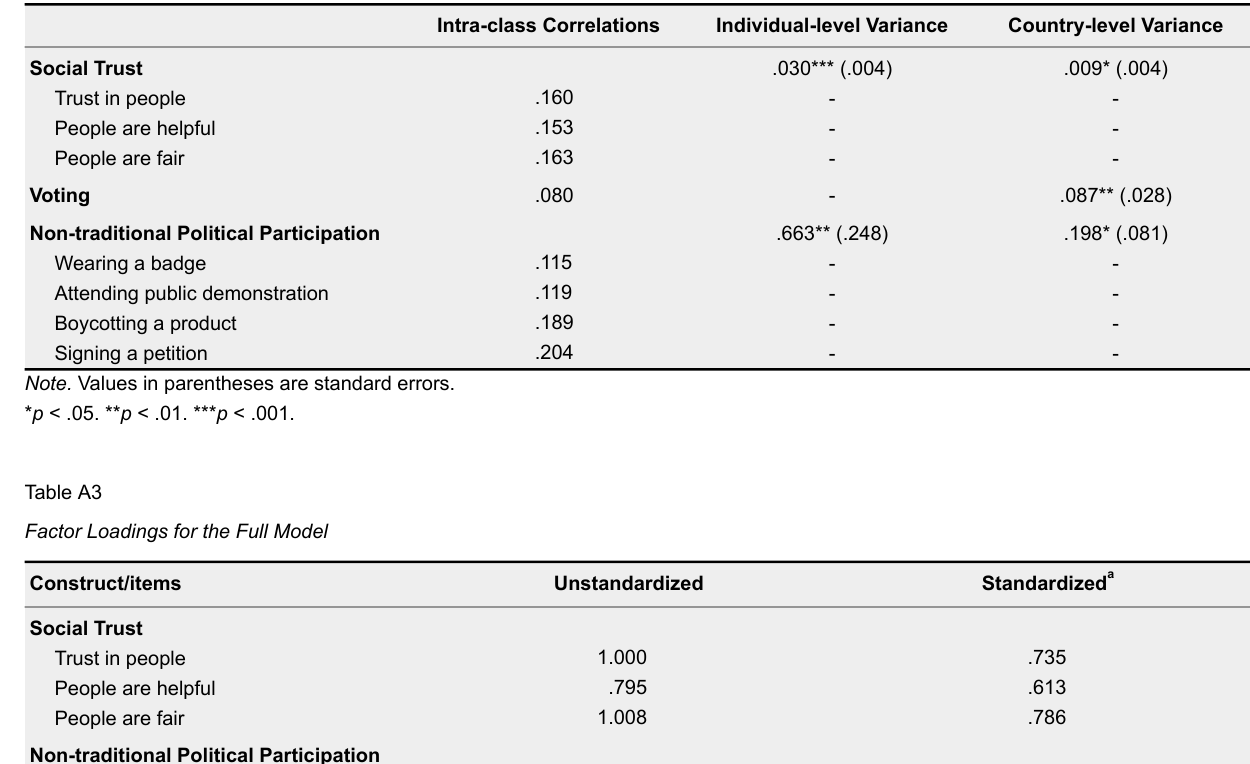
Intra-Class Correlations and Variance Components in the Random-Intercept Only Model